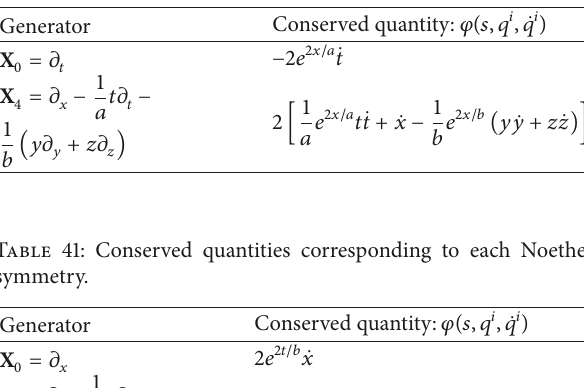
Table 40: Conserved quantities corresponding to each Noether symmetry.